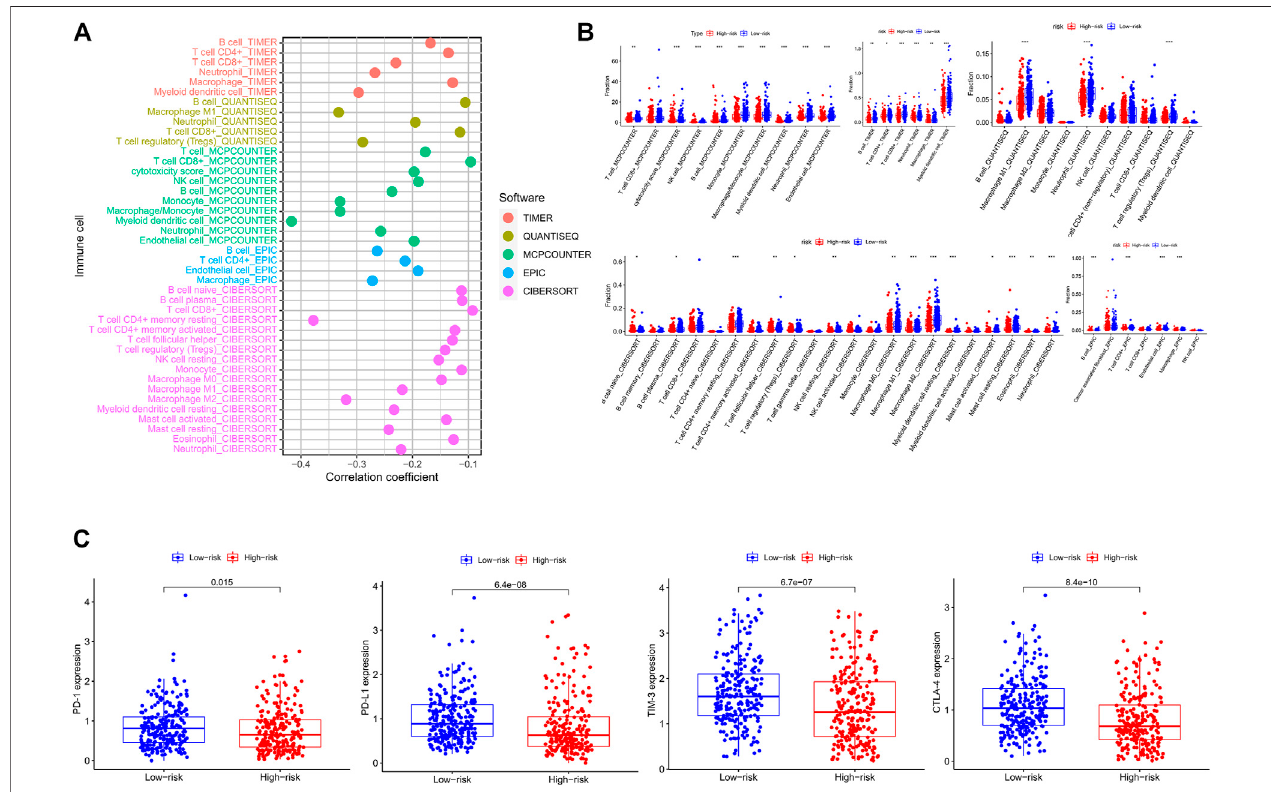
FIGURE 9 | Estimation of tumor-in fi ltrating immune cells and immune checkpoint biomarkers by the risk assessment signature. (A) Lollipop plot showing the correlations between the abundance of different TIIC and risk score calculated by Spearman correlation analysis. (B) The difference in abundances of different TIIC between the low- and high-risk groups based on distinct algorithms. (C) The difference in expression levels of immune checkpoint biomarkers between the low- and high-risk groups.